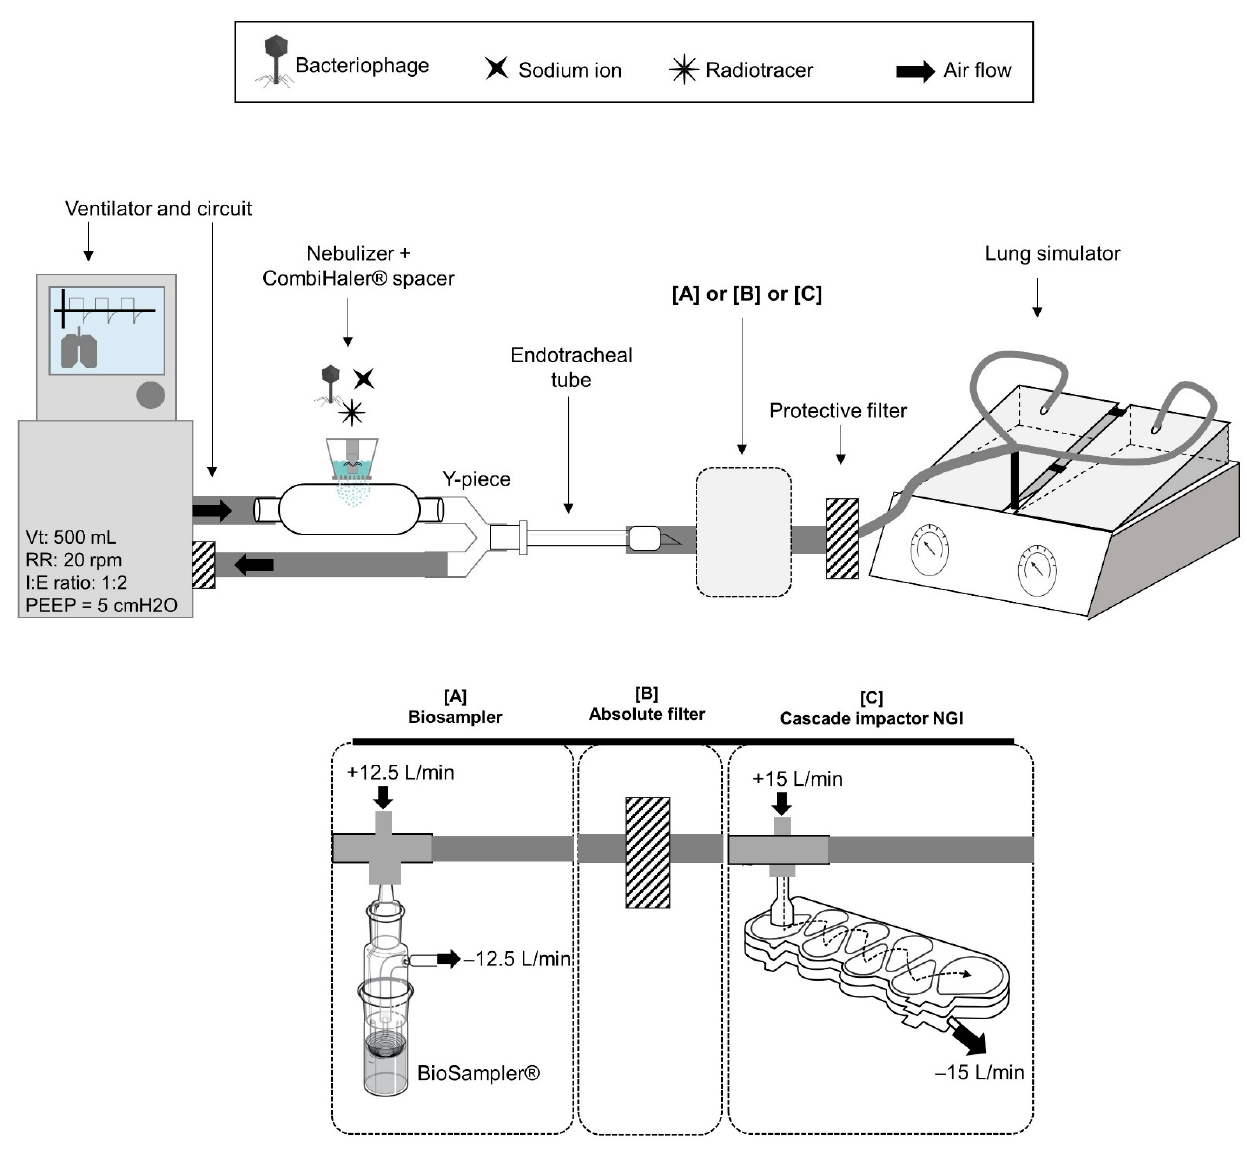
Figure 3. Bench study to assess the aerodynamic parameters of phage aerosol produced by nebulization during human mechanical ventilation. Mechanical ventilation was mimicked by connecting a ventilator, a ventilation circuit and an endotracheal tube to a lung simulator equipped with a protective filter. Nebulization of phages was ensured by the static-mesh nebulizer, associated with a Combihaler ® spacer and connected to the inspiratory lamb, just before the Y piece in reference to intensive care unit clinical practice. Three aerodynamic parameters of phage aerosol were measured at the endotracheal tube outlet: [A] phage viability, by inter-imposing the Biosampler ® (shunt connection), [B] the output as the quantity of aerosol delivered to the lung simulator, by using an absolute filter, [C] the particle size distribution of the aerosol, by inter-imposing a cascade impactor (shunt connection). In both [A] and [C] set-ups with a shunted connection, an additional airflow, equal to that of the vacuum pump was added to ensure the shunt connection to avoid ventilation modification. Nebulizer was loaded either with the AP-Phage mix in 0.9% NaCl alone, for set-up with [A], or combined with 37 MBq of radioactive tracer 99m Tc-DTPA for set-up with [B] or [C]. Standard ventilatory parameters were applied. Vt: tidal volume (500 mL), RR: respiratory rate (20 respiratory per minute), I:E: Inspiratory: Expiratory ratio (1:2), PEEP: Positive End Expiratory Pressure (5 cm H 2